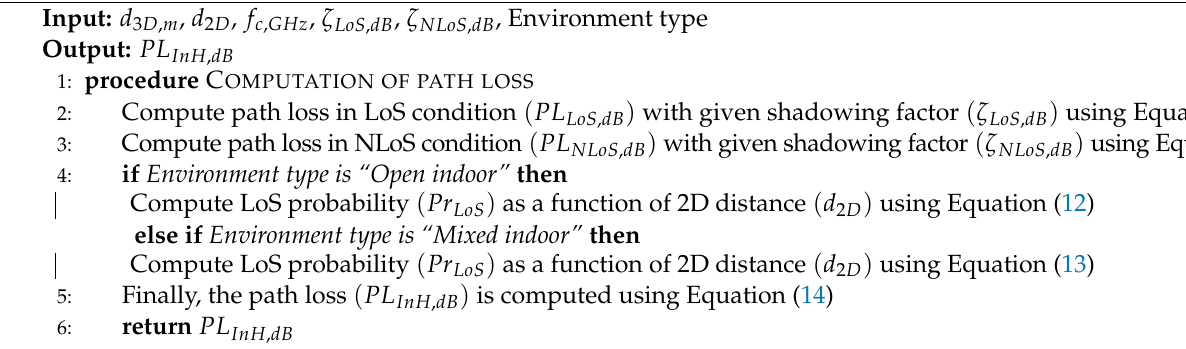
Algorithm 3 3GPP Indoor Hotspot (InH) propagation model